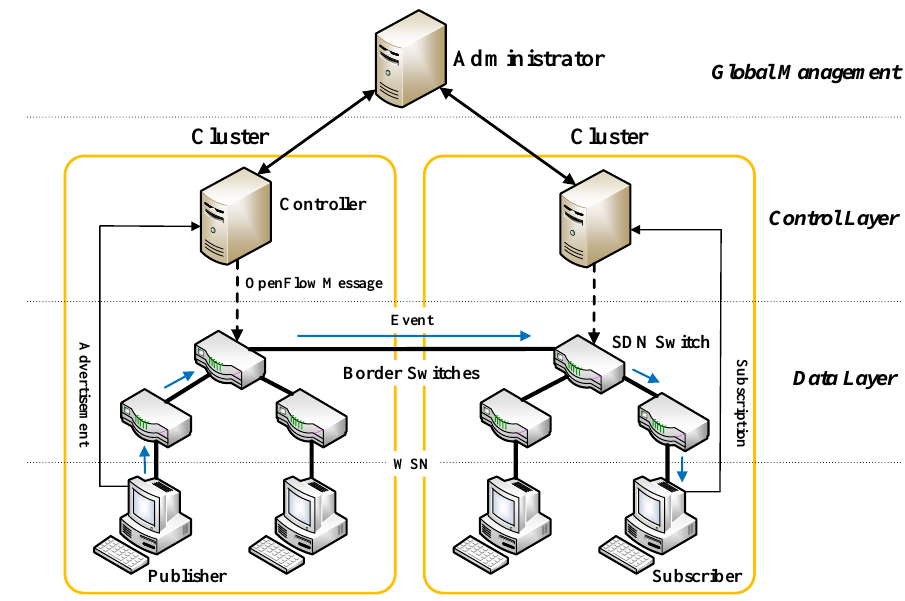
Figure 1. SDN-like pub/sub system